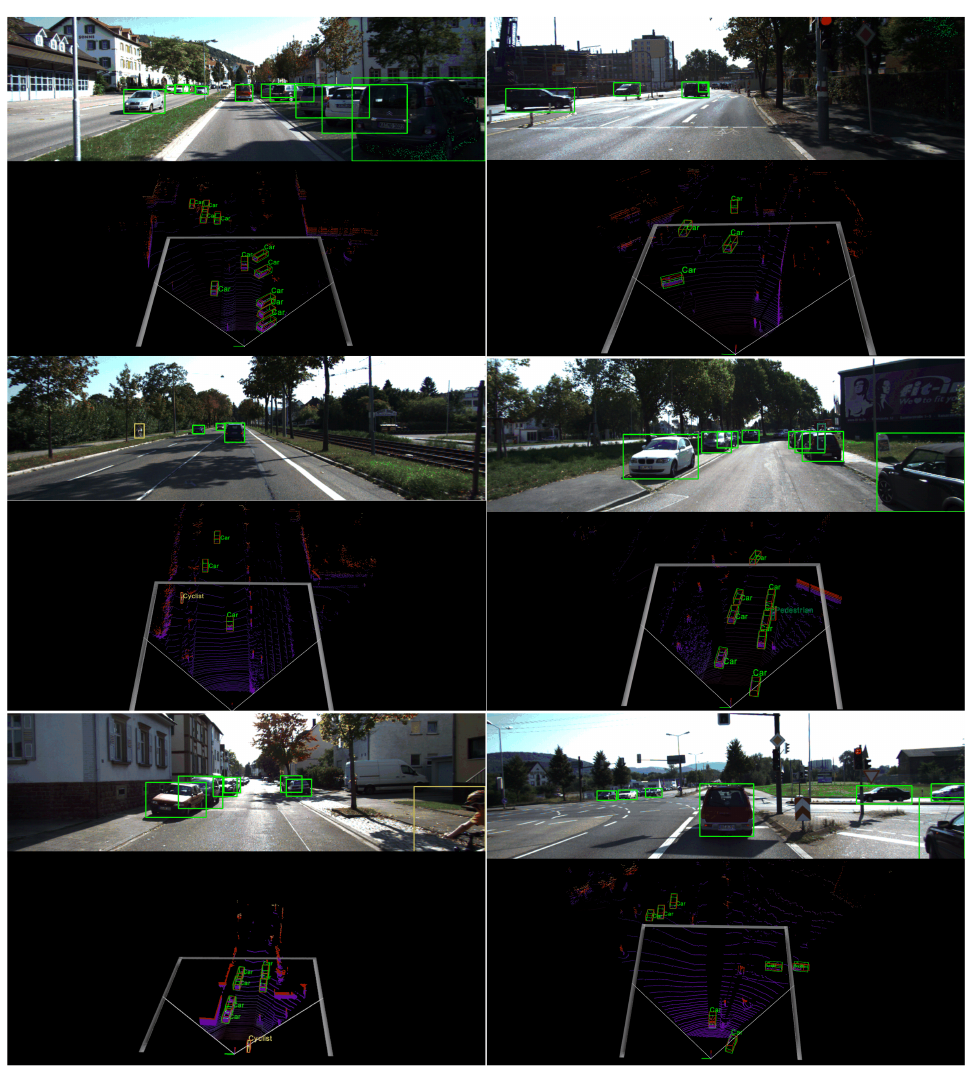
Figure 8. Visualization of the detection effect of the HA-RCNN model. The ground-truth bounding boxes are shown in red, and the predicted bounding boxes are shown in green for cars, cyan for pedestrians, and yellow for